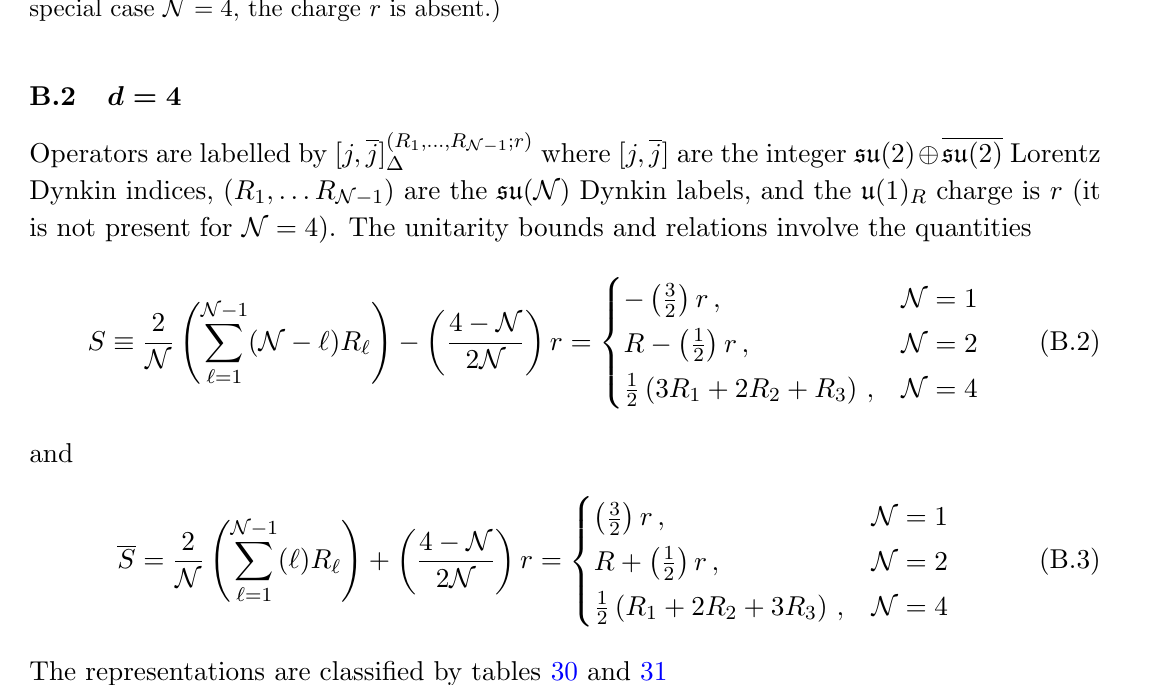
Table 30 . The chiral half of unitary representations of the 4 d superconformal algebras. (In the special case N = 4 ; the charge r is